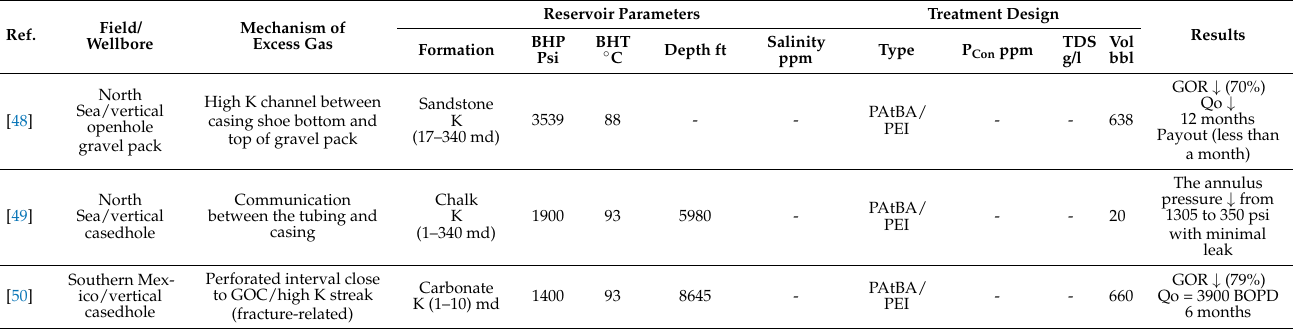
Table 6. PAtBA/PEI—gas shutoff treatments in oil production wells (GSOOs). Ref.